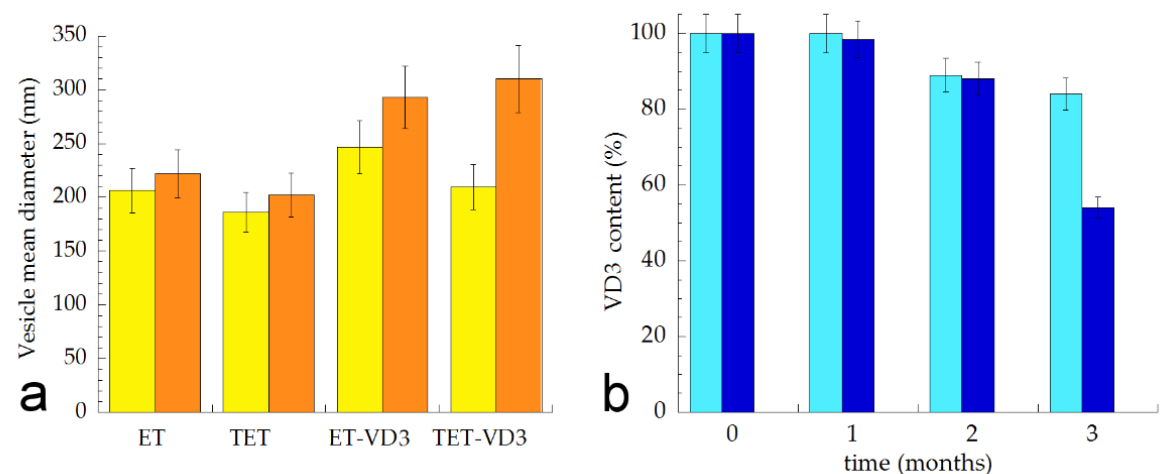
Figure 4. ( a ) Mean diameter variation for the indicated ET and TET. Mean diameters were measured by PCS after 0 (yellow) and 3 months (orange) from production and expressed as Z average. Data are the mean of three determinations on different samples; ( b ) Variation of VD3 content in ET-VD3 (light blue) and TET-VD3 (blue) determined up to 3 months from production. Bars indicate s.d.